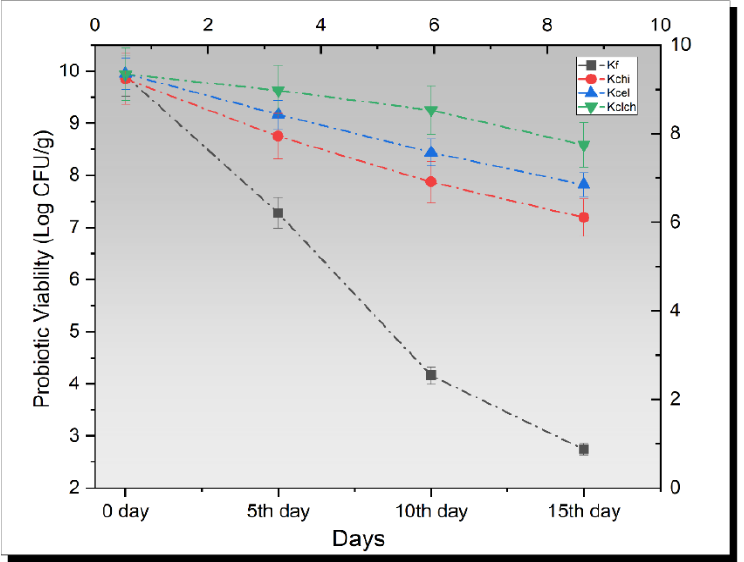
Figure 4. Viability of un-encapsulated and encapsulated (cellulose, chitosan, and cellulose–chitosan hybrid cells) probiotic microgels on the probiotic viability in kefir during storage interval (0, 5th, 10th, and 15th day) compared with control. Each line represents mean value for viability of treatments. C (un-encapsulated probiotics), Cch ( L. plantarum encapsulated with chitosan), Ccl (L. plantarum encapsulated with cellulose), and Cch-cl ( L. plantarum encapsulated with chitosan and cellulose hybrid cells).